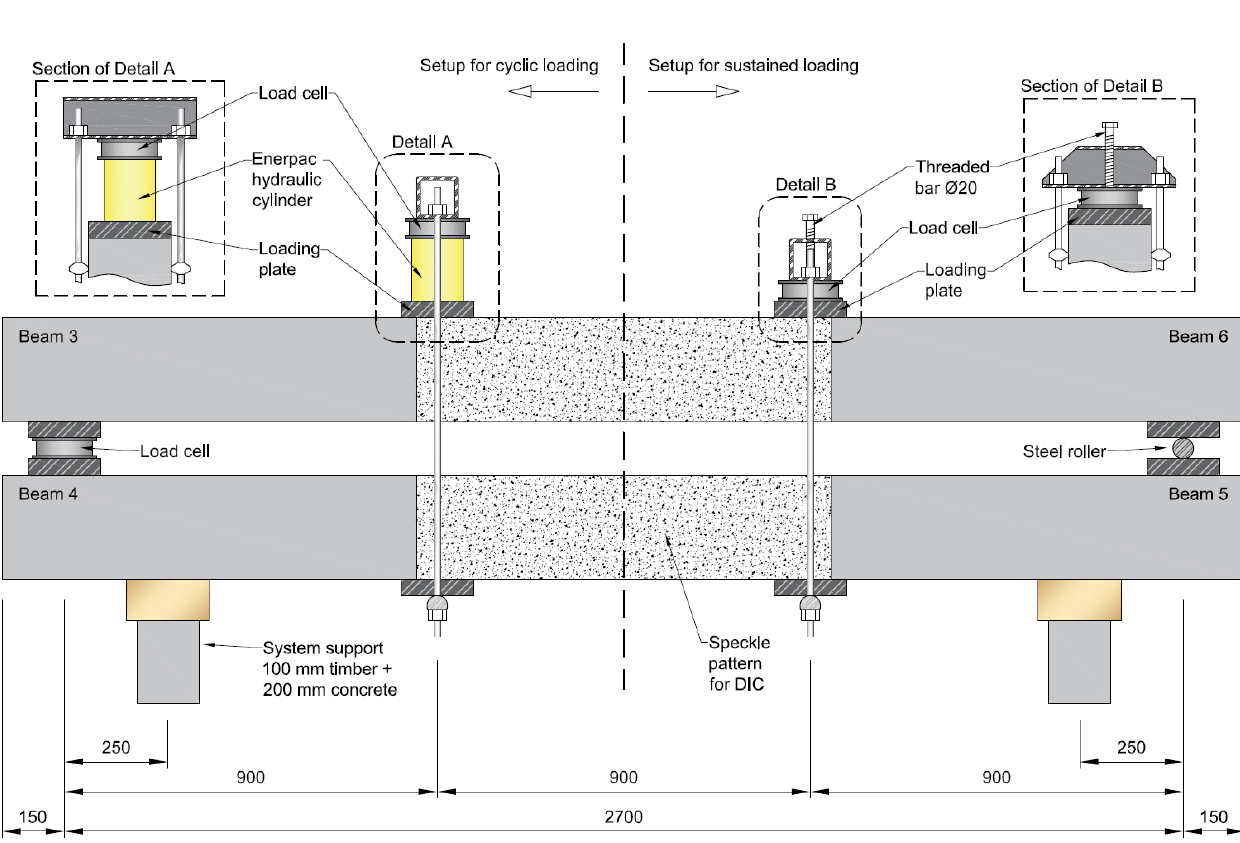
achieved by tightening a threaded bolt screwed into the clamping device, cf. Detail B in Figure 2. Two load cells were provisioned at the loading points over the top beam and one more between the support plates at one of the ends in order to ensure a symmetric load distribution. The load of the Enerpac hydraulic cylinder was automatically controlled using a close-loop feedback control system retrofitted with the measurement of the load- cells.